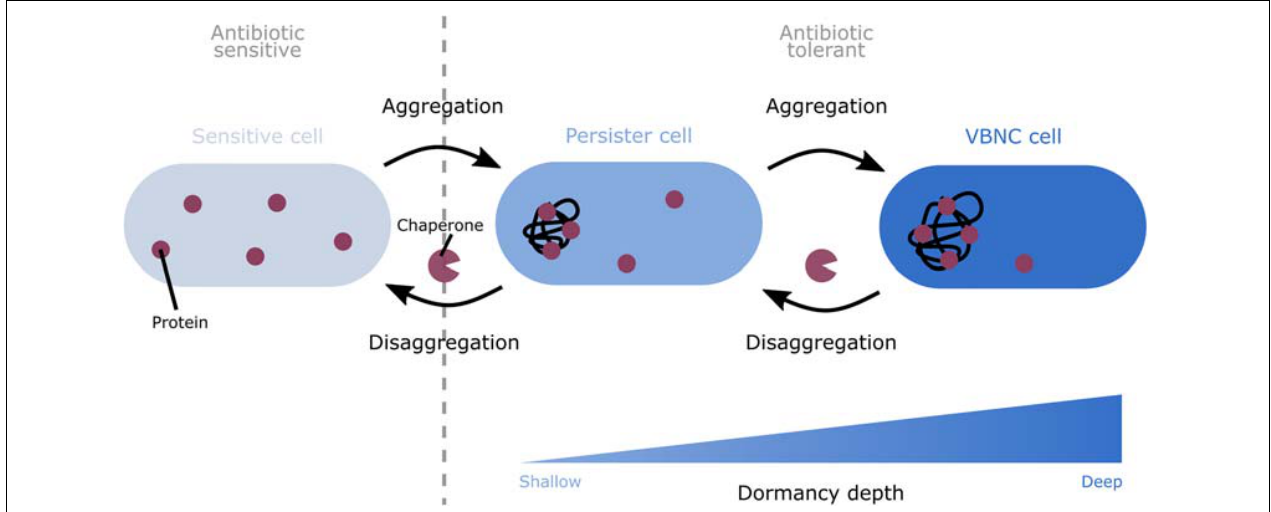
FIGURE 1 | A model depicting the role of protein aggregation in the formation and awakening of dormant cells. Progressive protein aggregation is proposed to induce the shift from sensitive to dormant cells. Aggregation can induce the switch from sensitive cells to the shallowly dormant persister state. Further development of the aggregates can cause a shift from persister cells to the deeper dormant VBNC state. This aggregation-induced dormancy renders cells tolerant to antibiotics. This tolerance is likely caused by the sequestration of proteins in the cell, thereby shutting down different important cellular pathways. To wake up again, these dormant cells likely first need to remove the aggregates. To perform this disaggregation, bacteria make use of